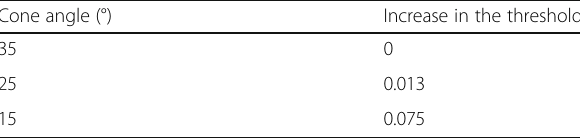
Table 4 Increase in the threshold values for reflectance tests on sunglint